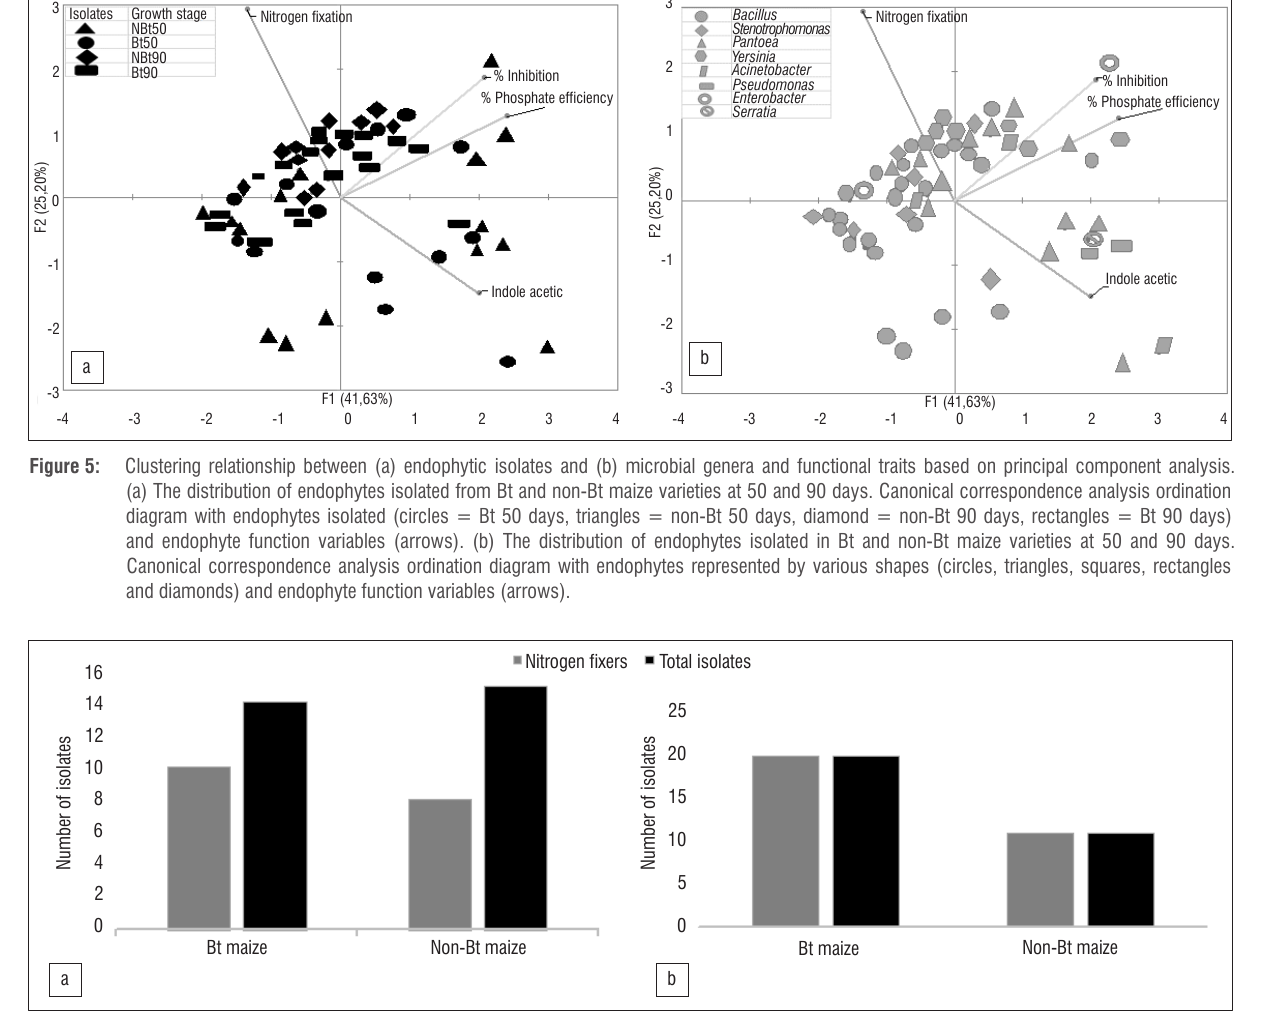
Figure 6: Total number of isolates which were shown to be potential nitrogen fixers in (a) 50-day-old maize isolates and (b) 90-day-old maize isolates.